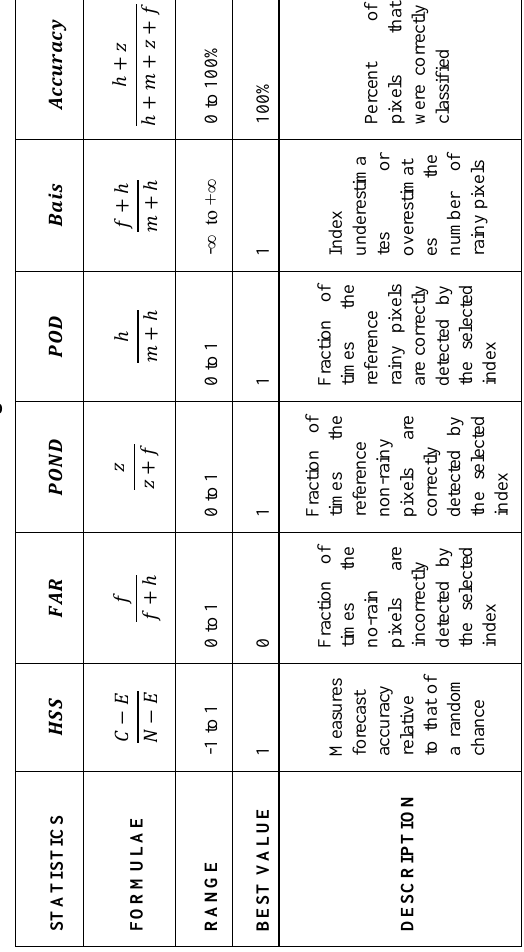
Figure 4. Flowchart of the